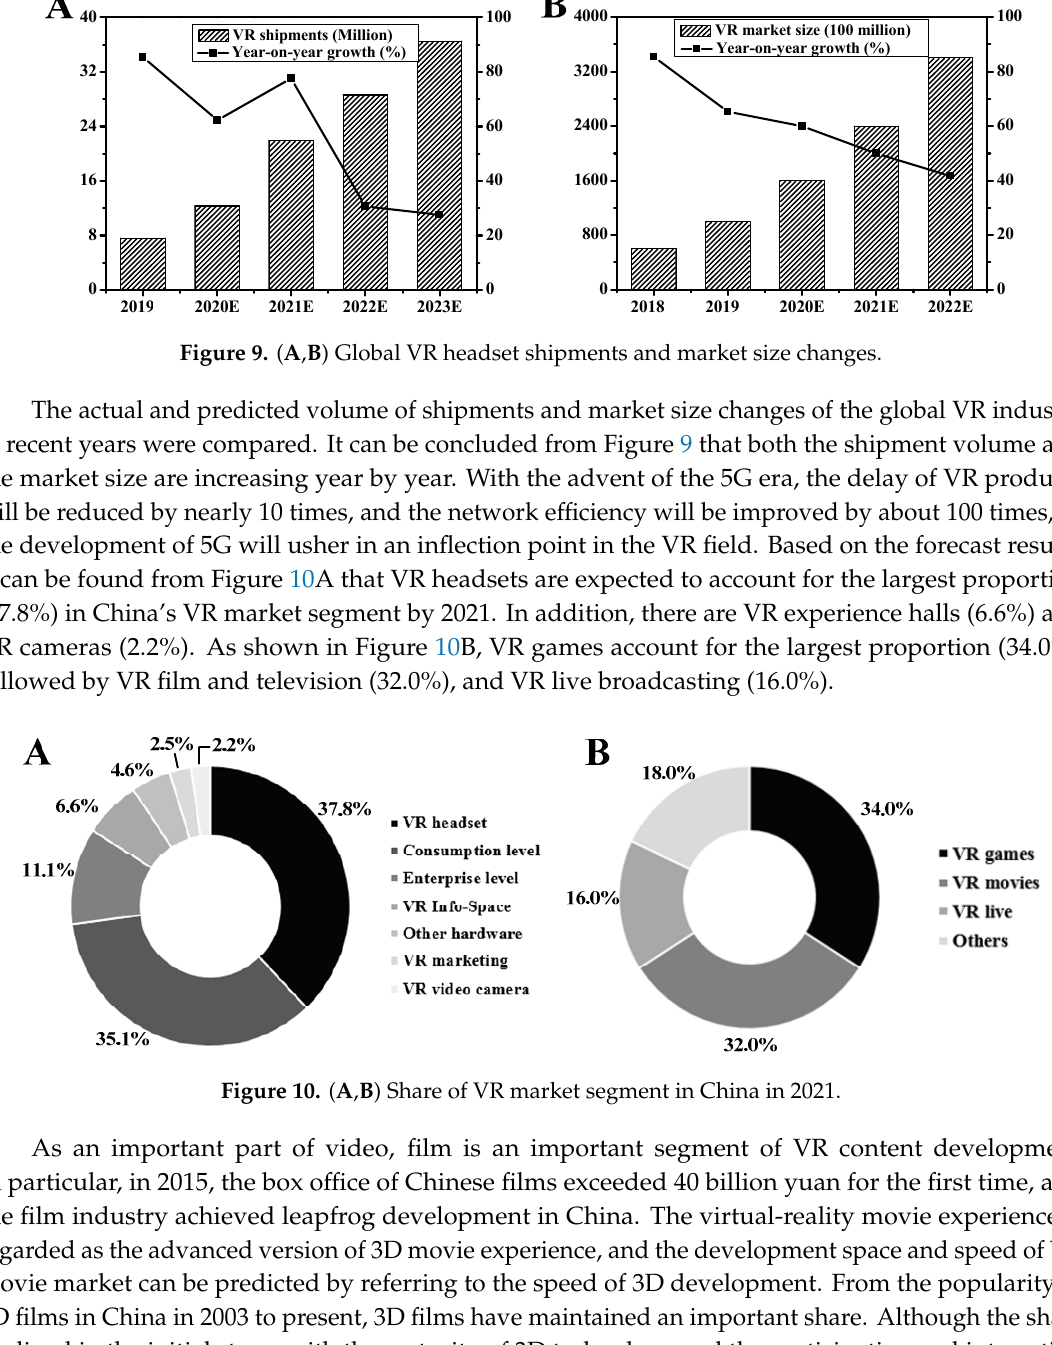
Figure 11. ( A-B ) The changing trend of VR film, television equipment, and live broadcasting market. As shown in Figure 12, the market size of Chinese sensors was about 99.5 billion yuan in 2015, and it reached about 160 billion yuan in 2019. The predicted results showed that the sensor scale in China will exceed 200 billion yuan in 2021. Sensor technology based on motion and expression capture is also gradually applied in VR film production. With the gradual expansion of China’s sensor market and the continuous development of VR technology, China’s AI film and television industry will show a trend of rapid development in the future.